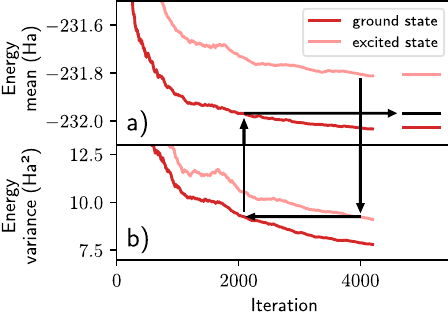
Fig. 8| Sketchofthevariance-matchingprocedure. Theexcitation energyofthe benzenecalculationatstep4000isobtainedforillustrationpurposes.Thevariance ( b ) of the excited state is higher than that of the ground state and is therefore matched with the variance of the ground state at a previous iteration. The excita- tion energy is computed by comparing the mean energies ( a ) at the respective iterations. This acts to reduce the excitation energy and is found to improve the results in all of our